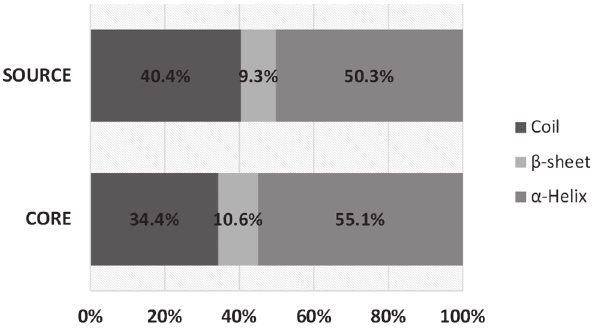
Fig 4. Statistical distribution of the secondary structures of AMP critical regions and the background.